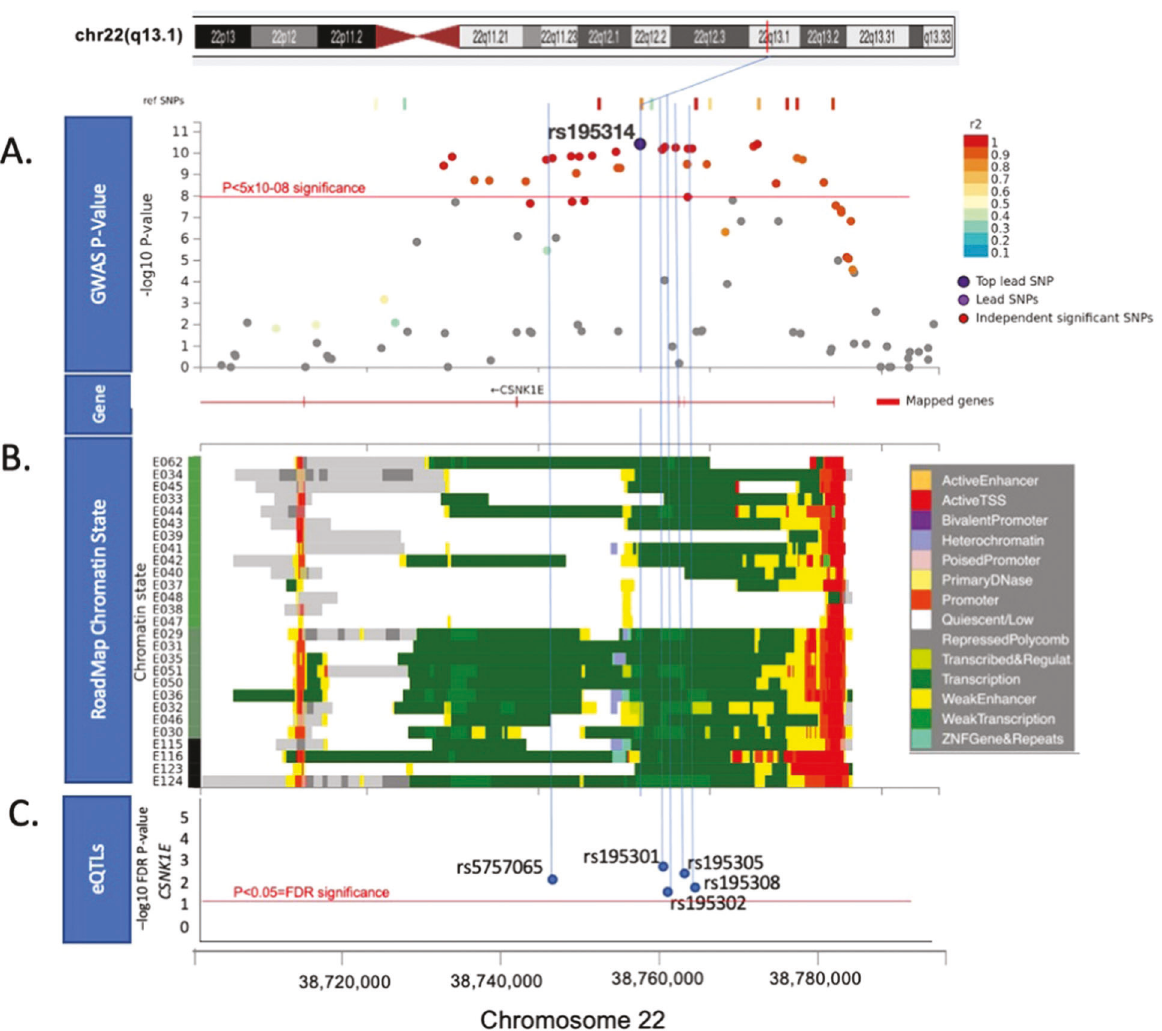
Fig. 2 Functional annotation of the rs195314 association. A Regional plot of the rs195314 22q13.1 association. B Roadmap Epigenome data for all blood, T-cell, HSC, and B cells. E029:Primary monocytes from peripheral blood; E030:Primary neutrophils from peripheral blood; E031: Primary B cells from cord blood; E032:Primary B cells from peripheral blood; E033:Primary T cells from cord blood; E034:Primary T cells from blood; E035:Primary hematopoietic stem cells; E036:Primary hematopoietic stem cells short term culture; E037:Primary T helper memory cells from peripheral blood 2; E038:Primary T help naive cells from peripheral blood; E039:Primary T helper naive cells from peripheral blood; E040: Primary T helper memory cells from peripheral blood 1; E041:Primary T helper cells PMA-Ionomycin stimulated; E042:Primary T helper 17 cells PMA-Ionomycin stimulated; E043:Primary T helper cells from peripheral blood; E044:Primary T regulatory cells from peripheral blood; E045: Primary T cells effector/memory enriched from peripheral blood; E046:Primary Natural Killer cells from peripheral blood; E047:Primary T CD8 naive cells from peripheral blood; E048:Primary T CD8 memory cells from peripheral blood; E-50:Primary hematopoietic stem cells G-CSF mobilized Female; E-51:Primary hematopoietic stem cells G- CSF mobilized Male; E062:Primary Mononuclear Cells from Peripheral Blood; E0116 Lymphoblastic Cell Line. The colors indicate chromatin states imputed by ChromHMM and shown in the key titled “ Roadmap Chromatin State ” . GWAS signi fi cant SNP rs195314 and other strong linkage disequilibrium (LD) SNPs are located in chromatin states noted as transcriptional sites across these hematological cell types. C eQTL analysis of CSNK1E cis-eQTLs from eQTLgen (https://www.eqtlgen.org/cis- eqtls.html). Y axis is -log false discovery rate (FDR) p value. X axis is base-pair location on chromosome 22. Red line indicates signi fi cant FDR p value